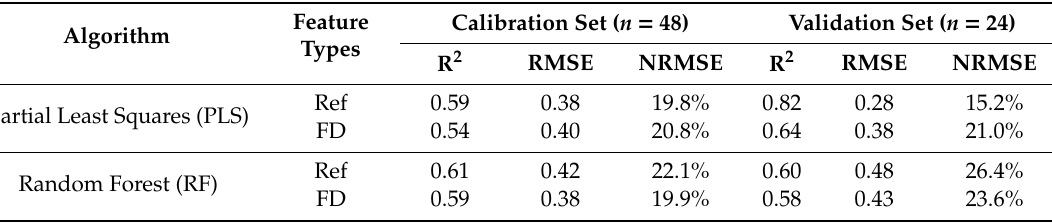
Table 4. Accuracy between the sensitive band and FD spectrum and